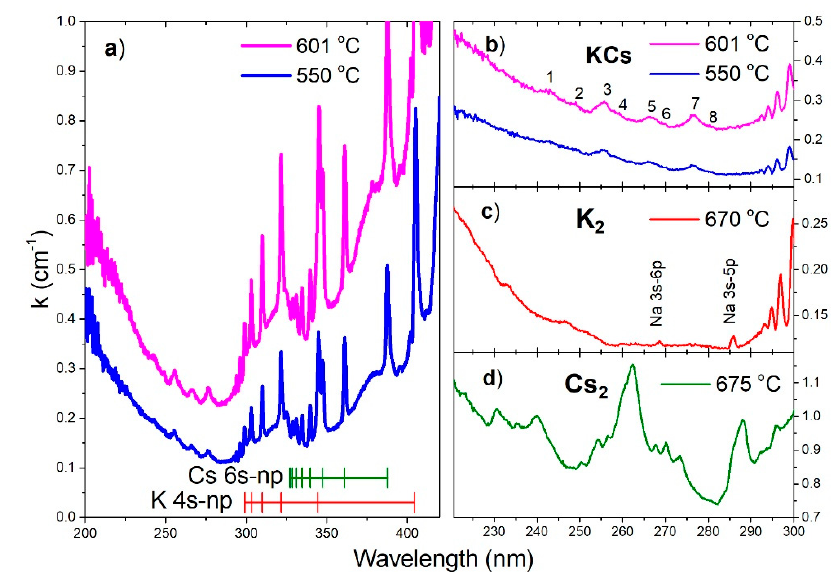
Figure 2. KCs absorption spectra for the two highest temperatures in the 200–420 nm spectral range (Figure 2 a ). Corresponding background light source was from the deuterium lamp. At the bottom right in Figure 2a, we put connected crosses denoting positions of the K and Cs Principal Series spectral lines from 5p to 10p and from 8p to 15p, respectively. An enlarged spectral region, 220–300 nm, is reproduced for (2 b ) KCs, (2 c ) K 2 , and (2 d ) Cs 2 cases. The (2 b ) KCs case shows the growing photoionization bands as listed in Table 1 from 1 to 8. T f = 601 °C means the temperature of the finger of the cell.